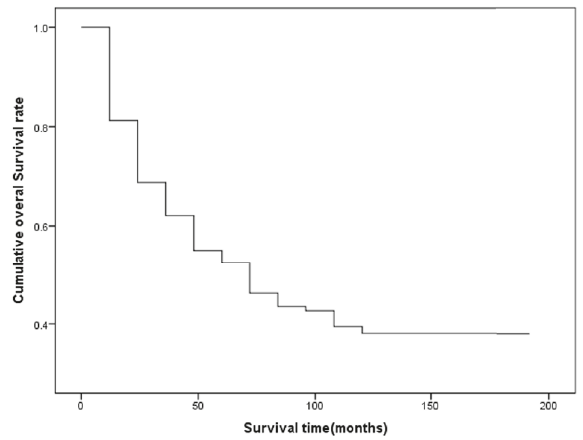
Figure 1: Overall survival rate among patients diagnosed with la- ryngeal cancer, South of Iran 2000–2015.